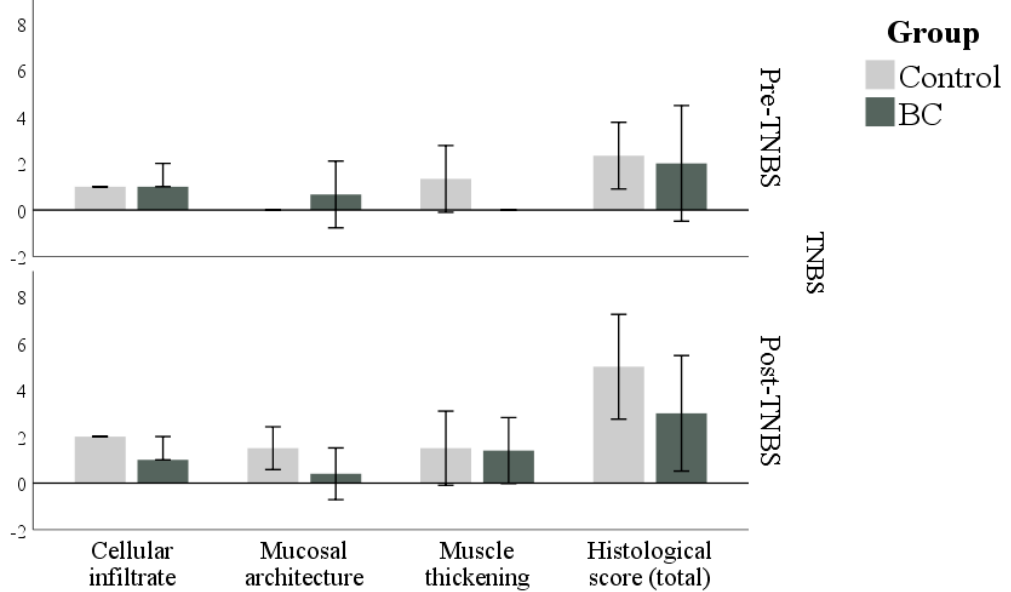
Figure 2. Scores for presence and grade of cellular infiltrate (Cellular infiltrate), the extent of destruction of normal mucosal architecture (Mucosal architecture), and Muscle thickening in addition to total score (histological score) in control and BC groups before (Pre-TNBS) and after (Post-TNBS) treatment with TNBS. No significant differences were found between the groups. Values are medians and 95% CI.